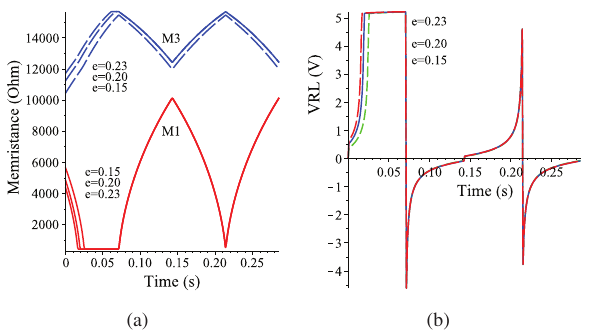
Fig. 11 : System excited by theta waves: periodic square wave voltage source with V 0 = 10 V , f = 7 Hz , x 1 ( 0 ) = x 4 ( 0 ) = 0 . 5 + e , x 2 ( 0 ) = x 3 ( 0 ) = 0 . 5 − e . (a) M 1 ( x ) and M 3 ( x ) dependent on t for different initial conditions, (b) V RL dependent on t for different initial conditions.